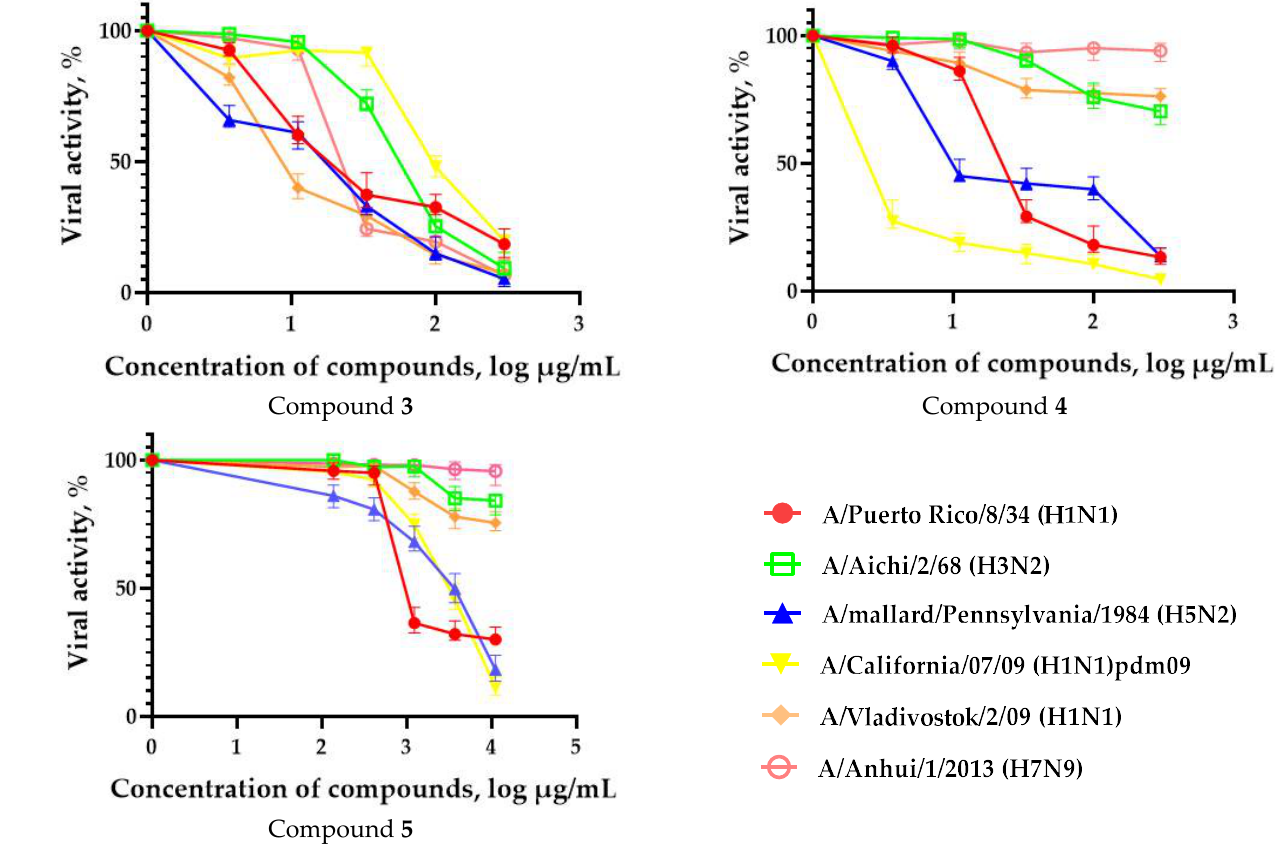
Figure 2. Spectrum of antiviral activity of leading fullerene derivatives ( 1 – 5 ). MDCK cells were infected with influenza viruses (MOI 0.01) and cultivated in the presence of compounds for 72 h followed by CPE reduction test. Figures represent 4-parameter log curves plotted using GraphPad Prism 6.01 for different subtypes of influenza virus. The values of viral activity (dots) are presented as mean ± SD of three independent experiments.